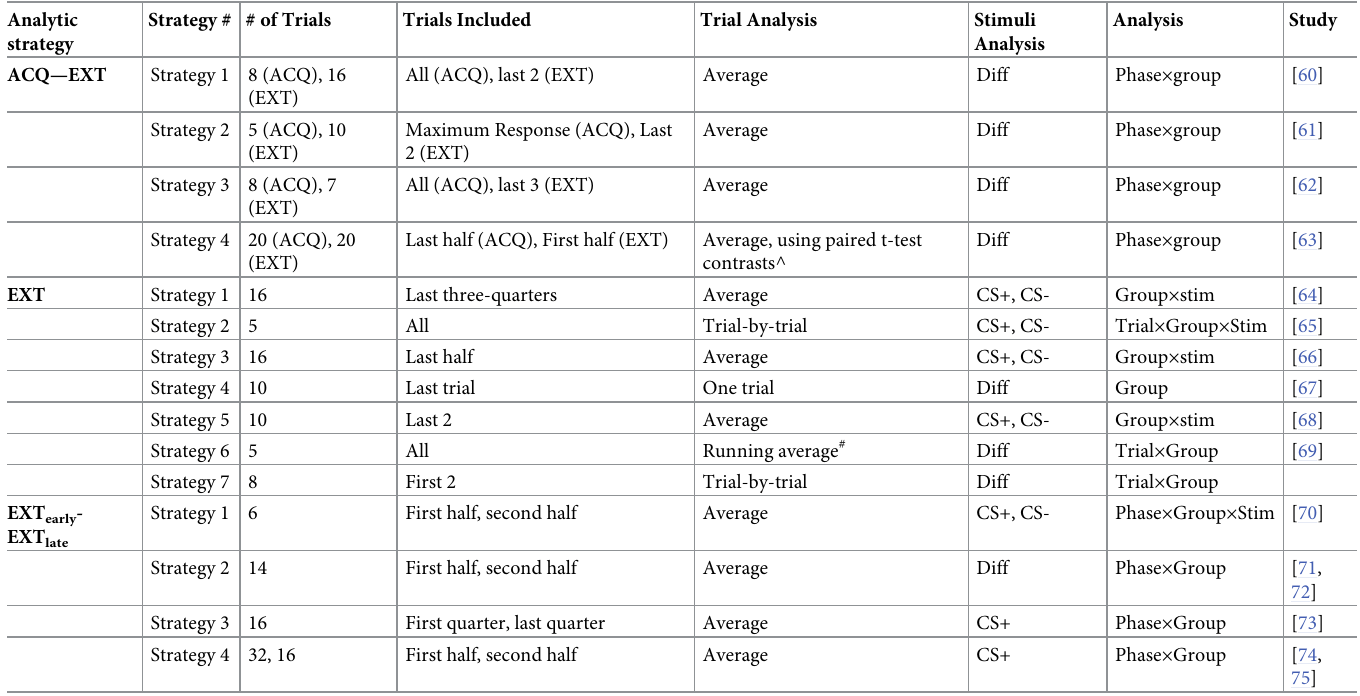
ACQ = Acquisition, EXT = Extinction, Diff = Differential, CS+ = Conditioned stimulus to the aversive unconditioned stimulus, CS- = Conditioned stimulus as a safety signal, Stim = stimulus type (CS+ v.